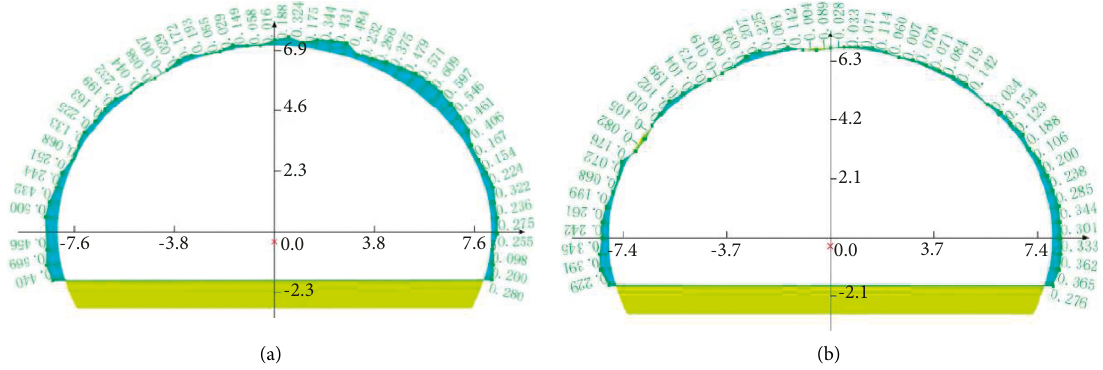
Figure 12: Scanning results of (a) conventional blasting technology and (b) ECHBT